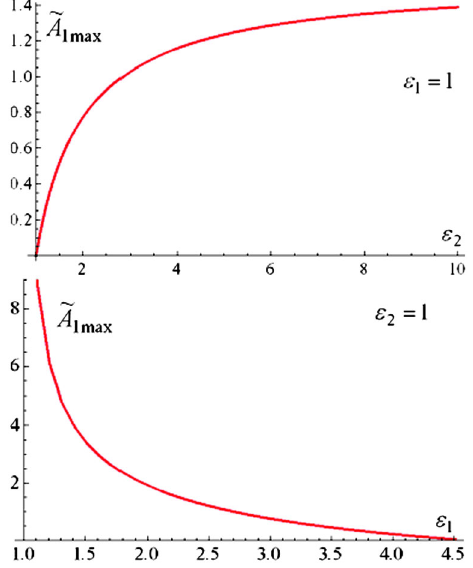
FIG. 4. The dependences of the threshold velocities (cid:1) , (cid:1) C 2 C 1 (solid red line) and (cid:1) 0 , (cid:1) 1 (dashed blue line) on the permittivity FIG. 5. The dependence of the maximum value of the KEG on " 2 or " 1 , respectively; the KEG is positive for (cid:1) < (cid:1) 0 if " 1 ¼ 1 the permittivity " 2 or " 1 : for " 1 ¼ 1 at (cid:1) ! 0 (top), and for " 2 ¼ 1 at (cid:1) ! (cid:1) if " 2 ¼ 1 (bottom). (top), and for (cid:1) 1 < (cid:1) < (cid:1) C 1 C 1